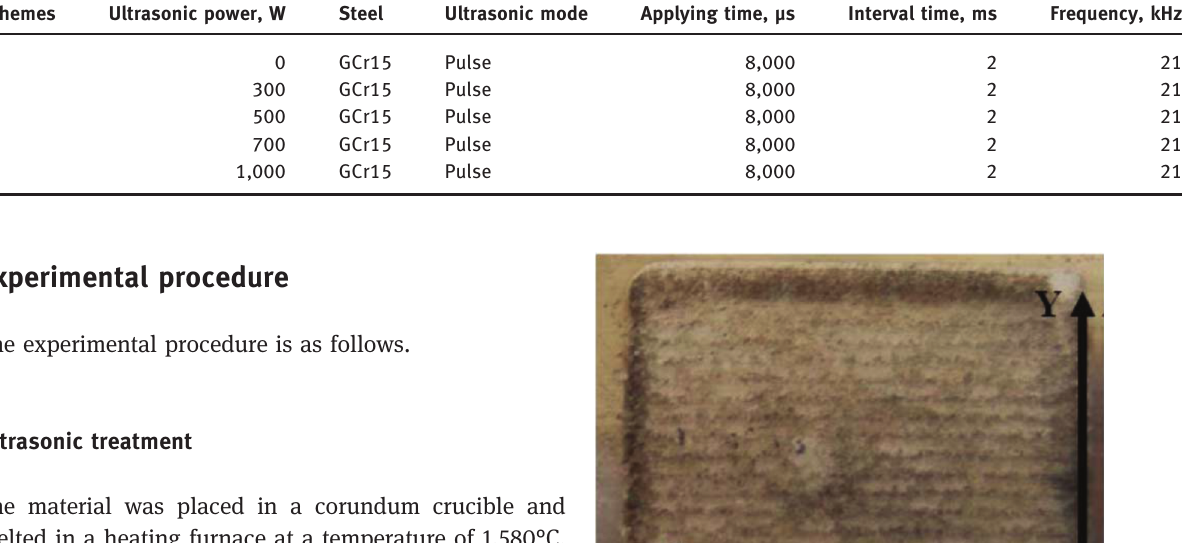
Table 1: Experimental schemes. Schemes